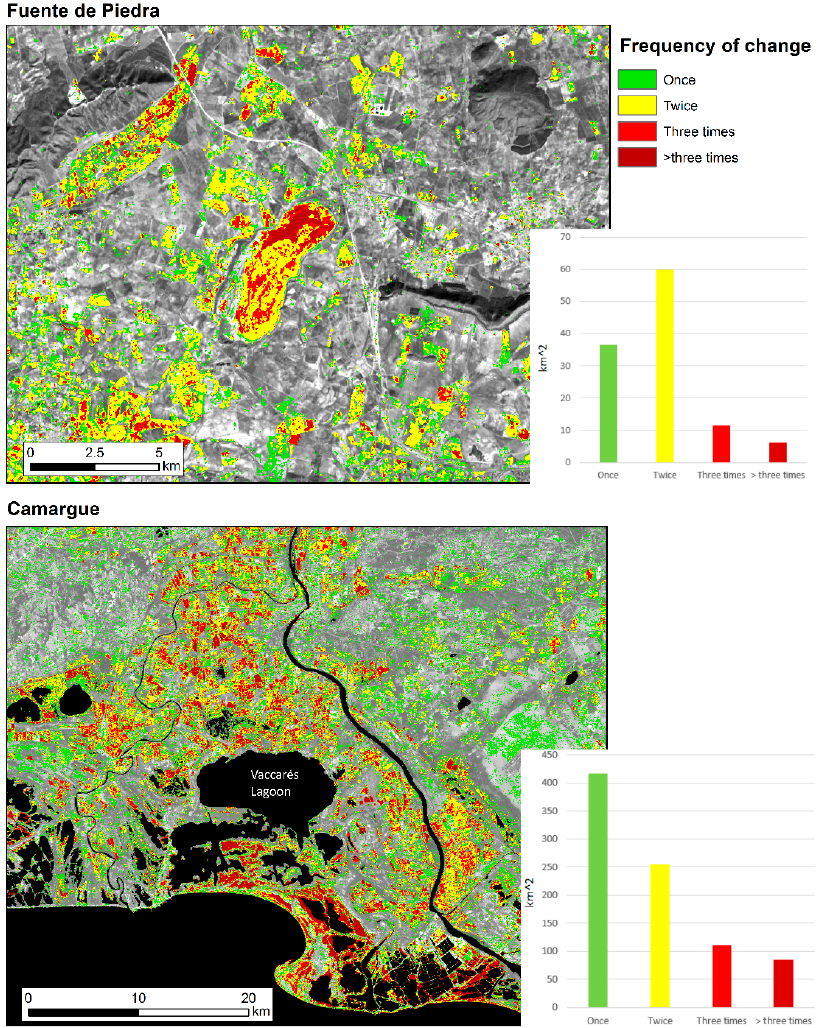
Figure 3. Frequency of change in Fuente de Piedra and Camargue. Colors indicate how many times a pixel has changed over the 12-month period. The charts aggregate the frequencies of change by area (Landsat 8 band 4 used as the background image).